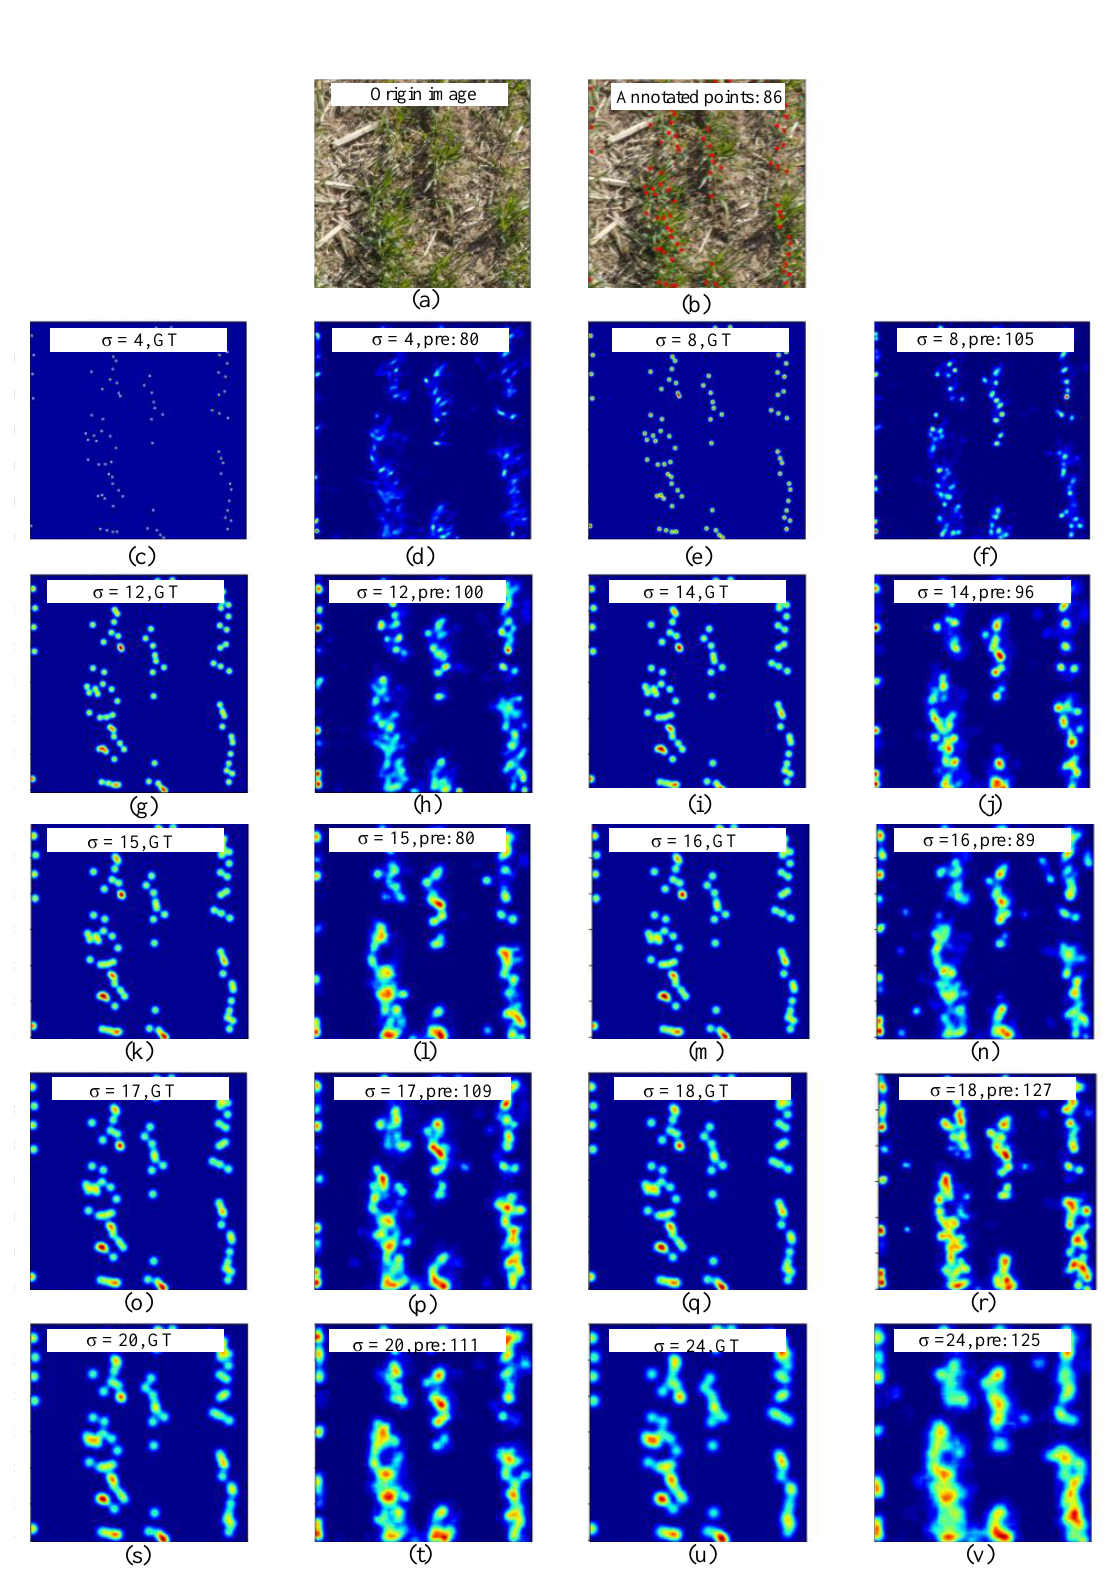
Figure 6. Examples of DeNet predictions with different sigma values in sensitivity analysis (4, 8, 12, 14, 15, 16, 17, 18, 20, and 24). ( a ) An example of an original image patch in the validation dataset. ( b ) The image patches with annotations. ( c , e , g , i , k , m , o , q , s , u ): heatmap generated from ground-truth with different sigma values. ( d , f , h , j , l , n , p , r , t , v ): heatmap predicted from the plant density model with different sigma values. GT: ground-truth; pre: predicted plant